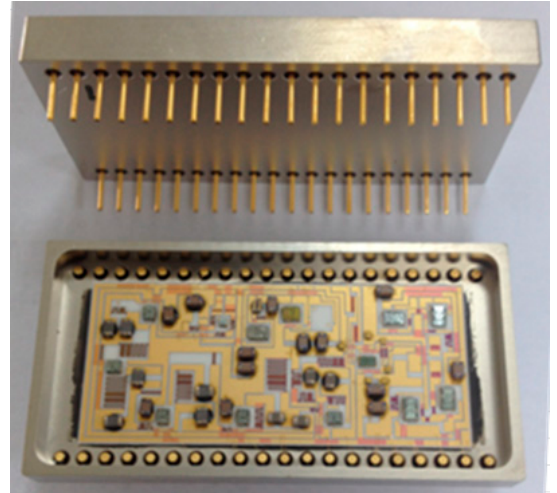
Figure 9. Photograph of the multi-chip module.